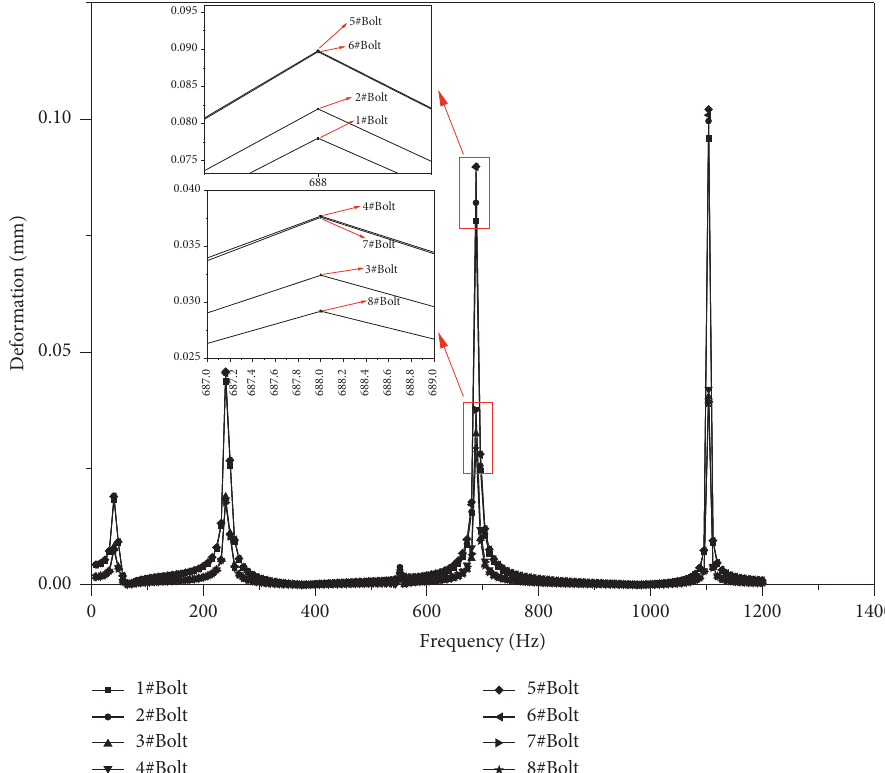
Figure 7: Spectrum response curve of bolt